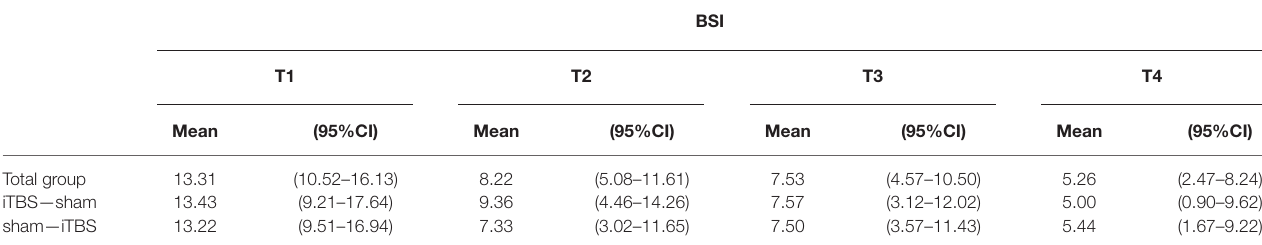
TABLE 1 | Beck scale of suicide ideation (BSI)